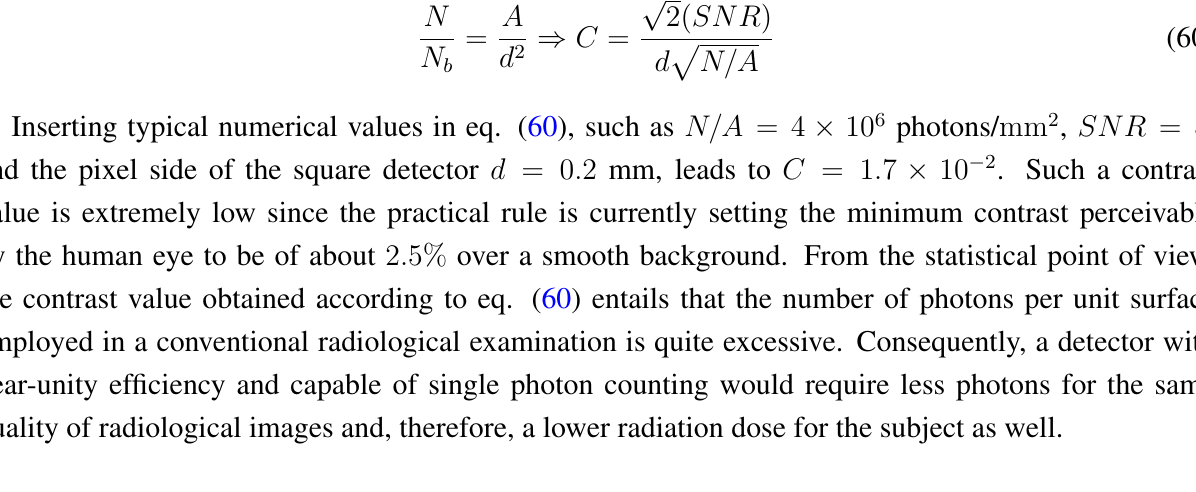
Table 1. Average recorded quanta around the incident point of the X-ray beam as resulted from simulations using GEANT for the most common X-ray